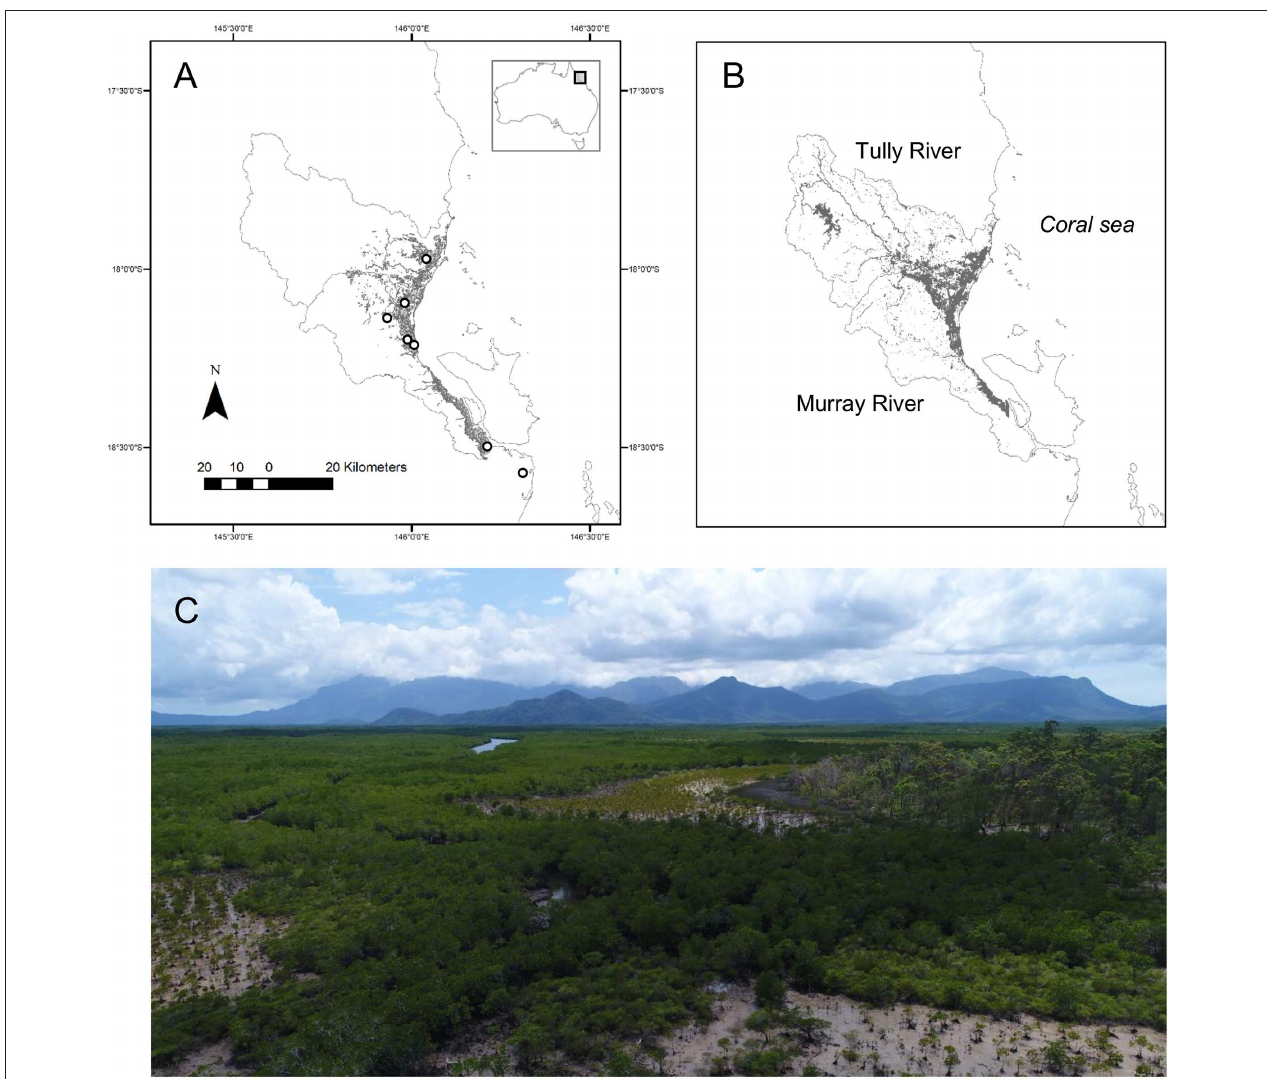
FIGURE 2 | (A) Wetland area within the catchments of the Tully-Murray River in tropical north-east Australia, and sampling locations from south to north: saltmarsh and mangroves at Hinchinbrook Channel, Melaleuca quinquenervia forest and freshwater marsh at Girramay National Park, lagoon with macrophytes (Nymphae spp. and grass at Barrett’s Lagoon), Melaleuca viridiflora forest at Hull Heads National Park, and Melaleuca-Eucalyptus spp forest at Djiru National Park, (B) flood extent after intense rainfall (863mm in 11 days) in March 30, 2018, and (C) composition of coastal wetlands with a mixture of Melaleuca forest, marshes and mangroves. Photo by MF